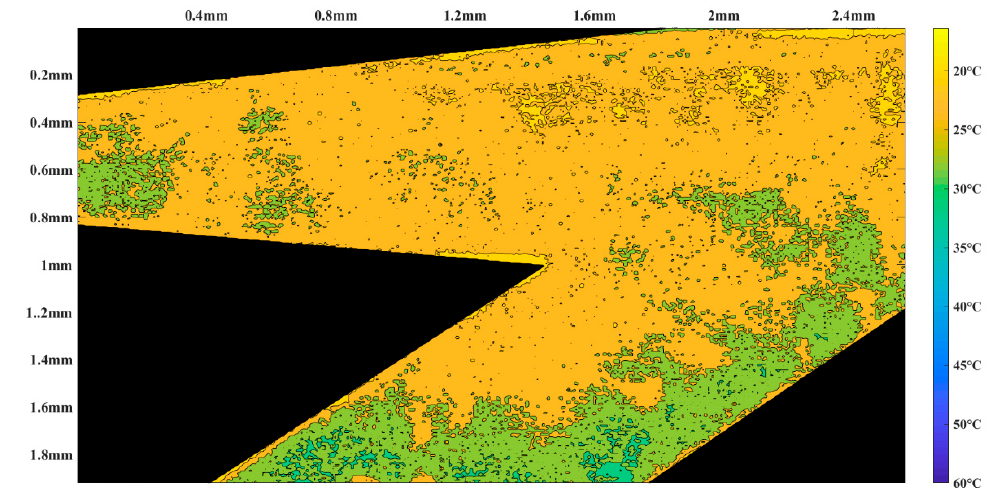
Figure 12. Temperature nephogram in the thermal bubble contraction stage.